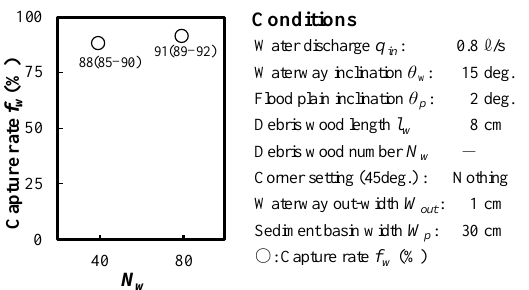
Figure 20. Effect of the difference in the amount of supplied wood debris on the capture rate.